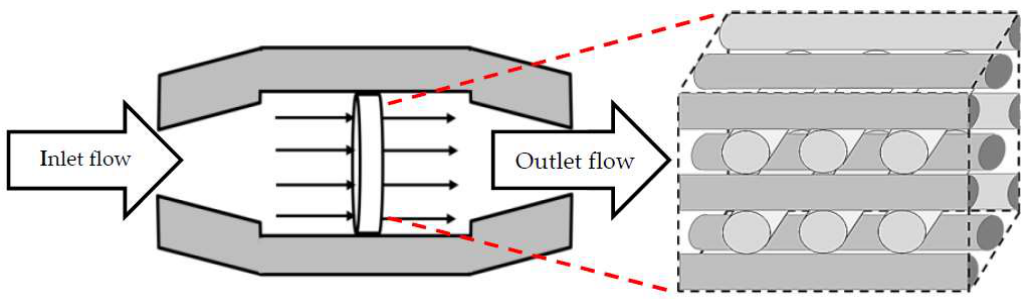
Figure 1. 3D fibrous scaffold placed in a perfusion micro-bioreactor.